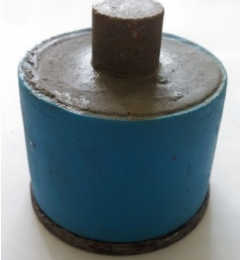
Figure 9. Sandstone core ready for adhesion testing on contact with cement